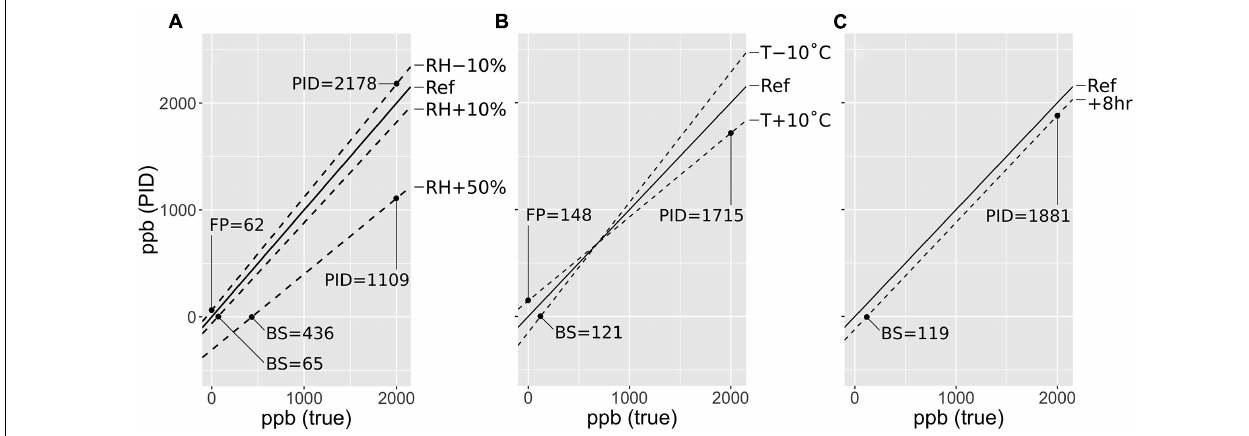
FIGURE 3 | A rough guide for assessing the importance of controlling for PID measurement error (commonly called ‘PID drift’) for a given application and environment. This figure shows estimated outcomes of PID measurements of a gas ranging from 0 to 2000 ppb using the standard onboard calibration method, and measuring under varying sample relative humidity (RH, A ), instrument temperature (T, B ), and time (C) . Conditions are specified at the right of each panel, with ‘Ref’ representing conditions during PID calibration. Sensitivities are derived from Figure 2 . PID measurement error can manifest as ‘blind spots’ (BS) where the PID reads zero for non-zero gas concentrations, false positives (FP) where the PID reads non-zero for zero gas concentrations, and inaccuracies in non-zero gas readings (sensor responsivity). RH will be the most important concern for most users, though direct sun exposure can cause large changes in T. Controlling or correcting for PID measurement error will be most important for applications requiring lower detection limits, precision, and accuracy better than approximately 500–1000 ppb. This should be used only as a rough guide, as PID sensitivities likely differ between